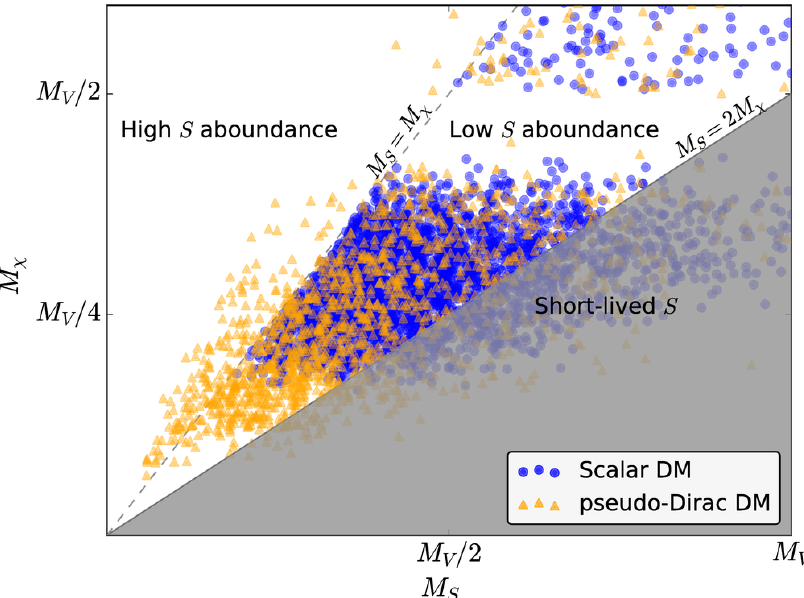
Figure 9. The four phenomenologically distinct regions described in the text shown in the dark matter mass M (cid:31) versus the dark Higgs boson mass M S plane with data points from the CS case (blue) and the pDF case (orange) which satisfy all the constraints considered in this analysis. The grey-shaded regions mark the two regimes where the phenomenology does not signi(cid:12)cantly di(cid:11)er from previous